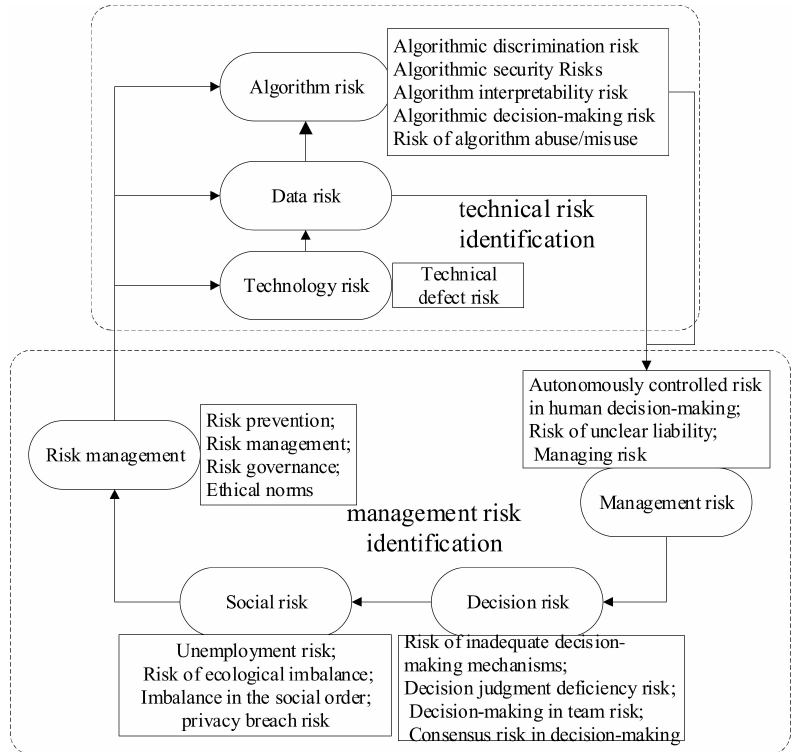
Figure 3. Conceptual model of ethical risk factors for AI decision